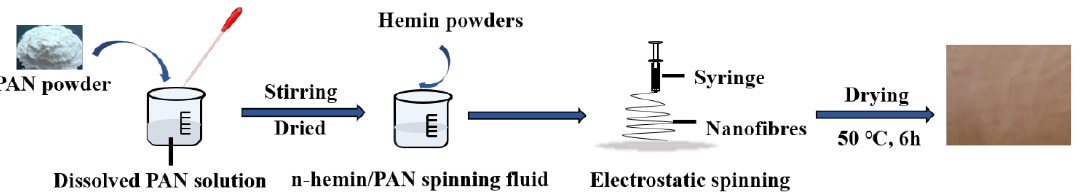
Figure 1. The preparation diagram of n-hemin/PAN.